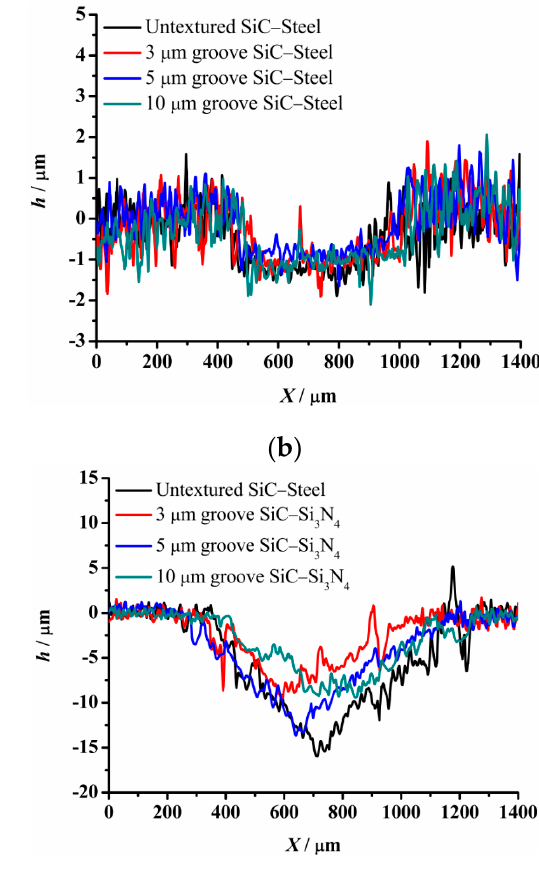
Figure 10. Cross section of wear scars under dry-friction conditions with a load of 30 N: ( a ) circular-dimple-texture SiC– steel ball, ( b ) groove-textured SiC–steel ball, ( c ) circular-dimple-textured SiC–Si3N4 ball, and ( d ) groove-textured SiC– Si3N4 ball.